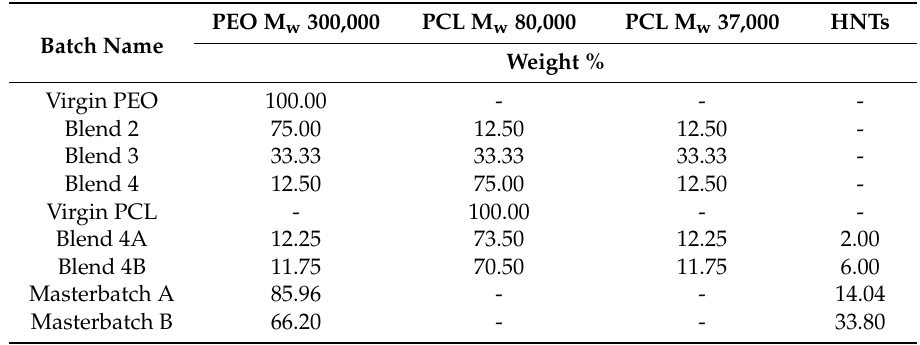
Table 1. Batch compositions prepared. PEO: Poly(ethylene oxide); PCL: Poly( ε -caprolactone); HNTs: Halloysite nanotubes.